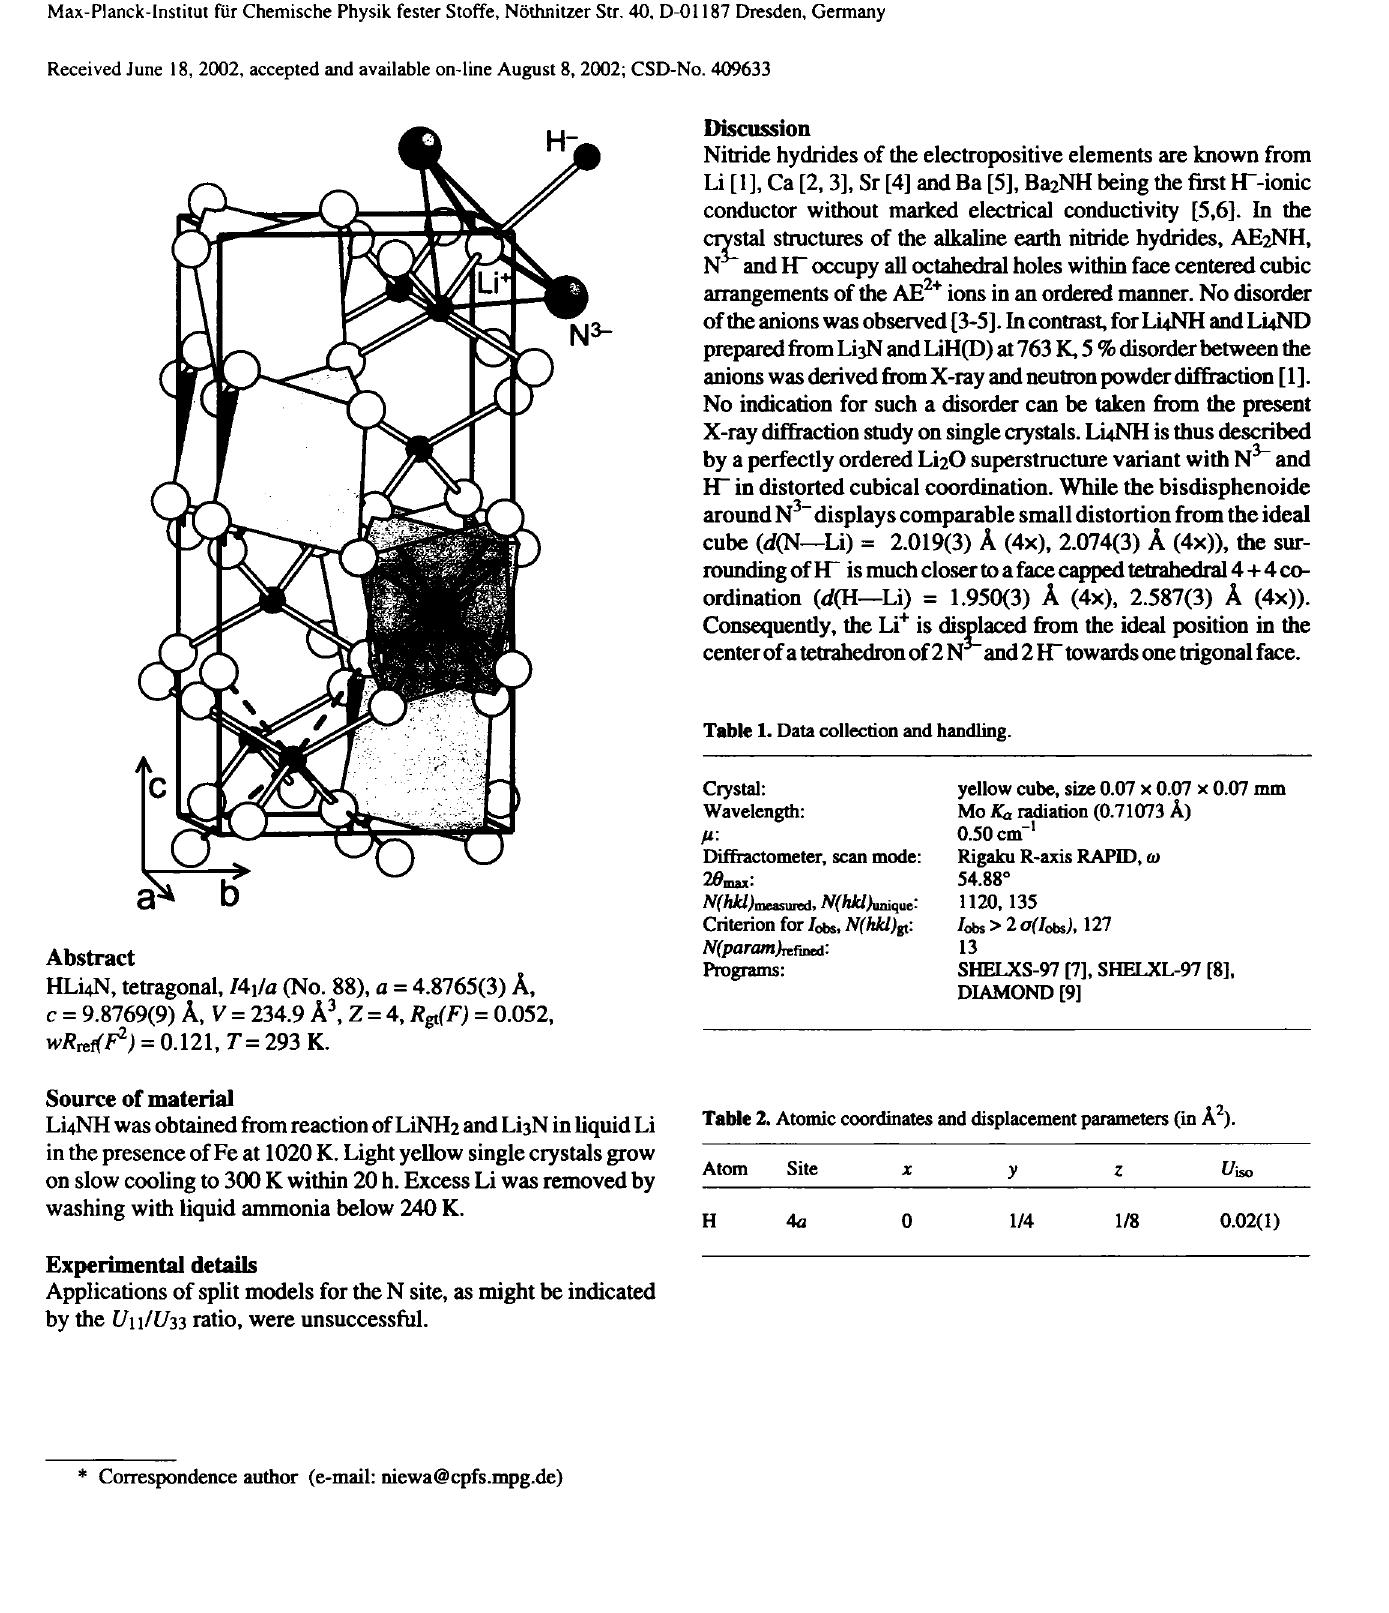
Table 2. Atomic coordinates and displacement parameters (in Â 2